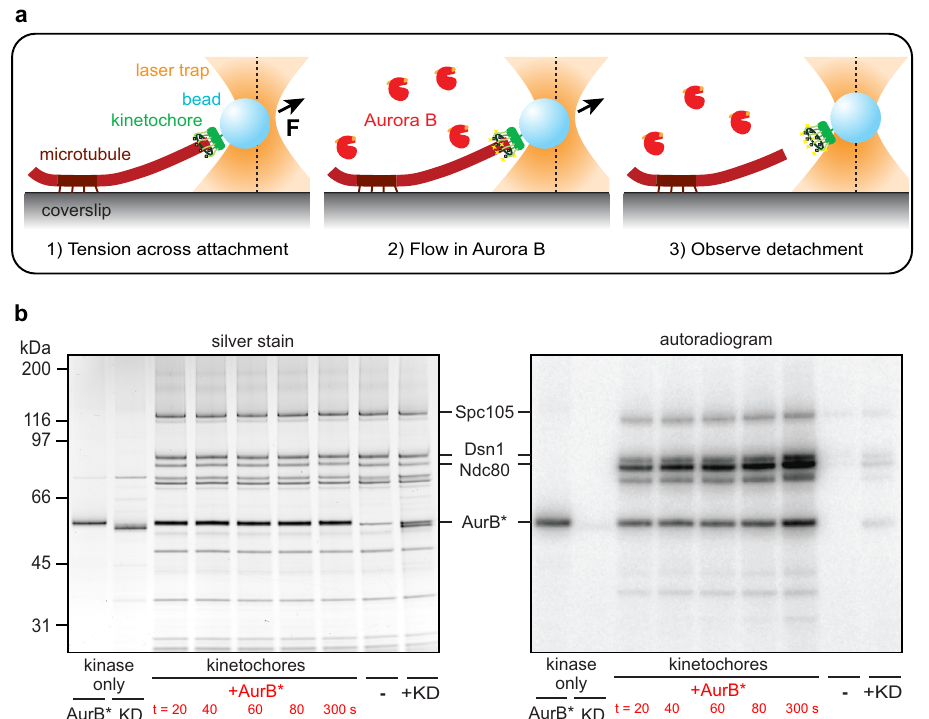
Fig. 1 Optical trap fl ow assay for testing whether tension affects Aurora B-triggered release of kinetochore-microtubule attachments. a Schematic of the assay. A kinetochore-decorated bead is attached to the growing tip of a microtubule anchored to a coverslip. Tension is applied with an optical trap, and free kinase is introduced by gentle buffer exchange. Tip-tracking of the kinetochore-bead is monitored until detachment or interruption of the experiment. b An engineered Aurora B construct phosphorylates kinetochores rapidly. Mps1-1 kinetochores (puri fi ed from SBY8726) were incubated with either 0.2 μ M active AurB* or 0.2 μ M kinase-dead mutant AurB*-KD in the presence of 32 P- γ -labeled ATP and then visualized by silver stain and autoradiography. The fi rst two lanes show AurB* or AurB*-KD alone with no kinetochores after 5 min of incubation, the next fi ve lanes show a time course of kinetochores incubated with AurB* for the indicated durations, and each of the last two lanes show kinetochores incubated with either no kinase or AurB*-KD for 3.5 min. The relevant Aurora B substrates are labeled and the positions of protein standards (kDa) are shown on the left. Ndc80 incorporation of 32 P is quanti fi ed in Supplementary Fig. 1b. Source data are provided as a Source Data fi